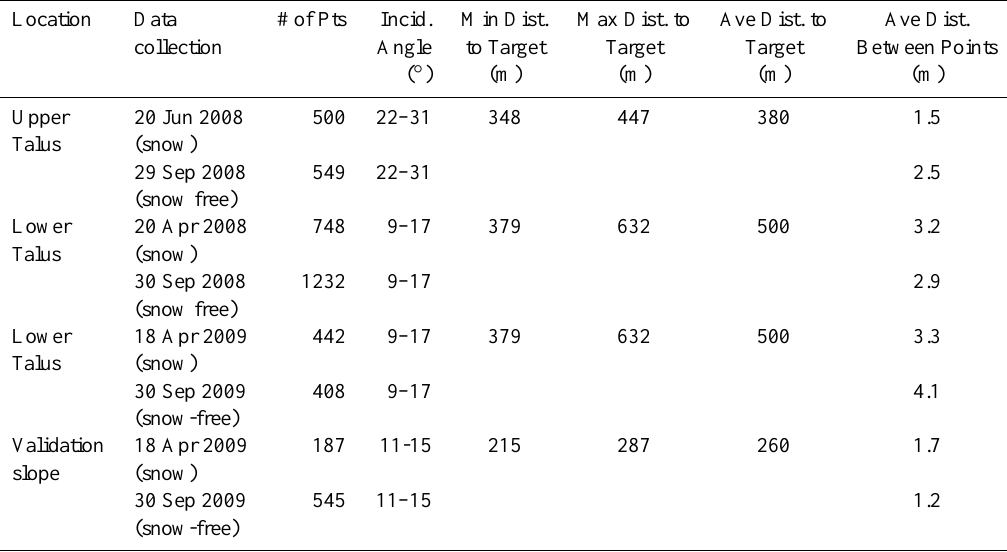
Table 2. Laser data collection date, number of points, incidence angle, distance to target and distance between points for four laser surveys. Location Data # of Pts Incid. Min Dist. Max Dist. to Ave Dist. to Ave Dist. collection Angle to Target Target Target Between Points ( ◦ ) (m) (m) (m) (m)